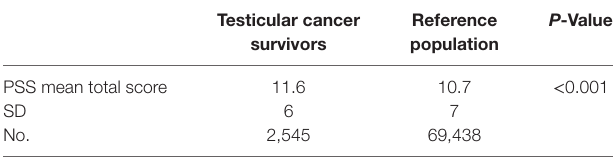
Table 3 | Perceived stress scale (PSS), total